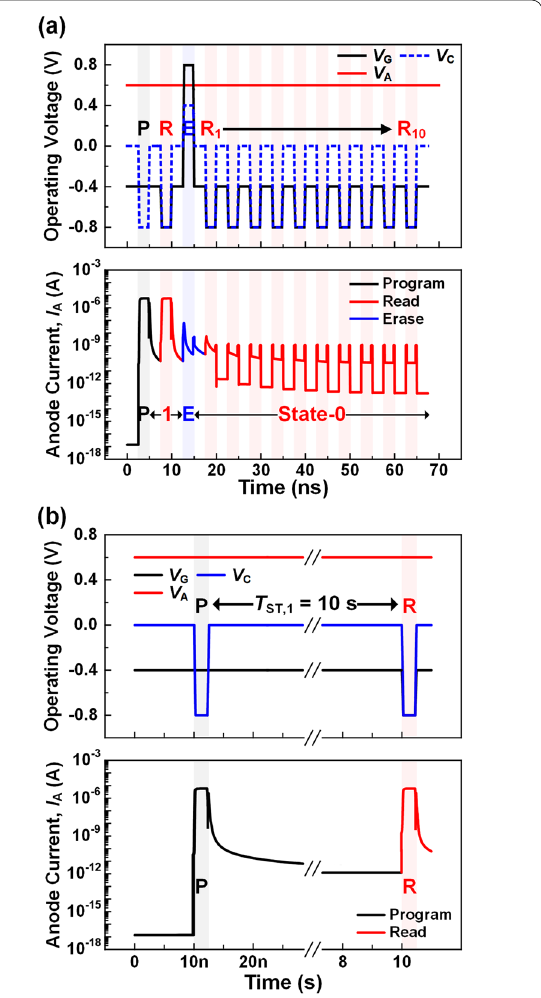
Fig. 8 Operating voltage and anode current a when ten consecutive read operations are applied after the erase operation and b when a read operation is applied at T ST,1